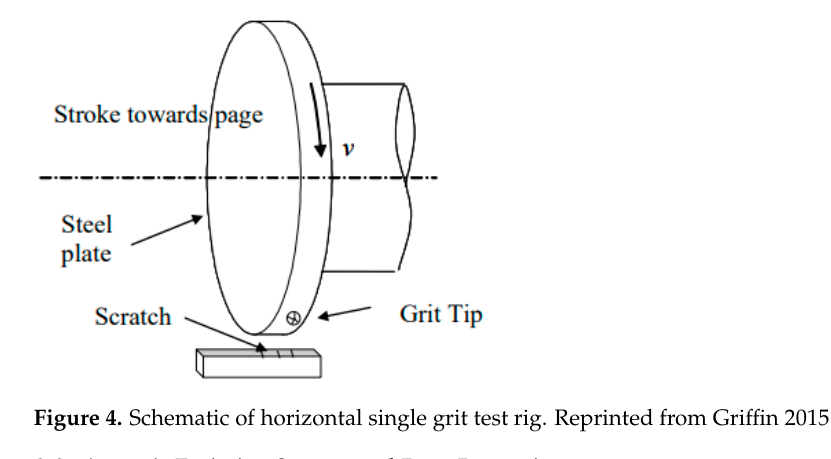
Figure 3. Single grit test set up. Reprinted from Griffin 2015 [21].